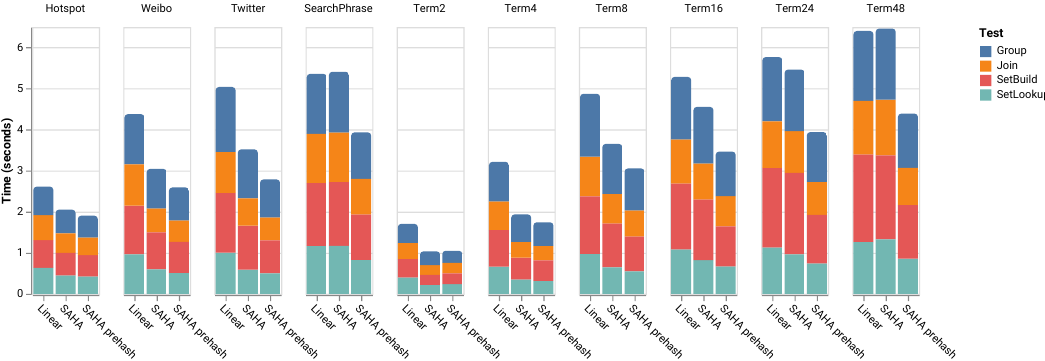
Figure 11. A bar graph of accumulated runtime of Linear , SAHA and SAHA with pre-hashing enabled for SetBuild, SetLookup, group and join benchmarks on all